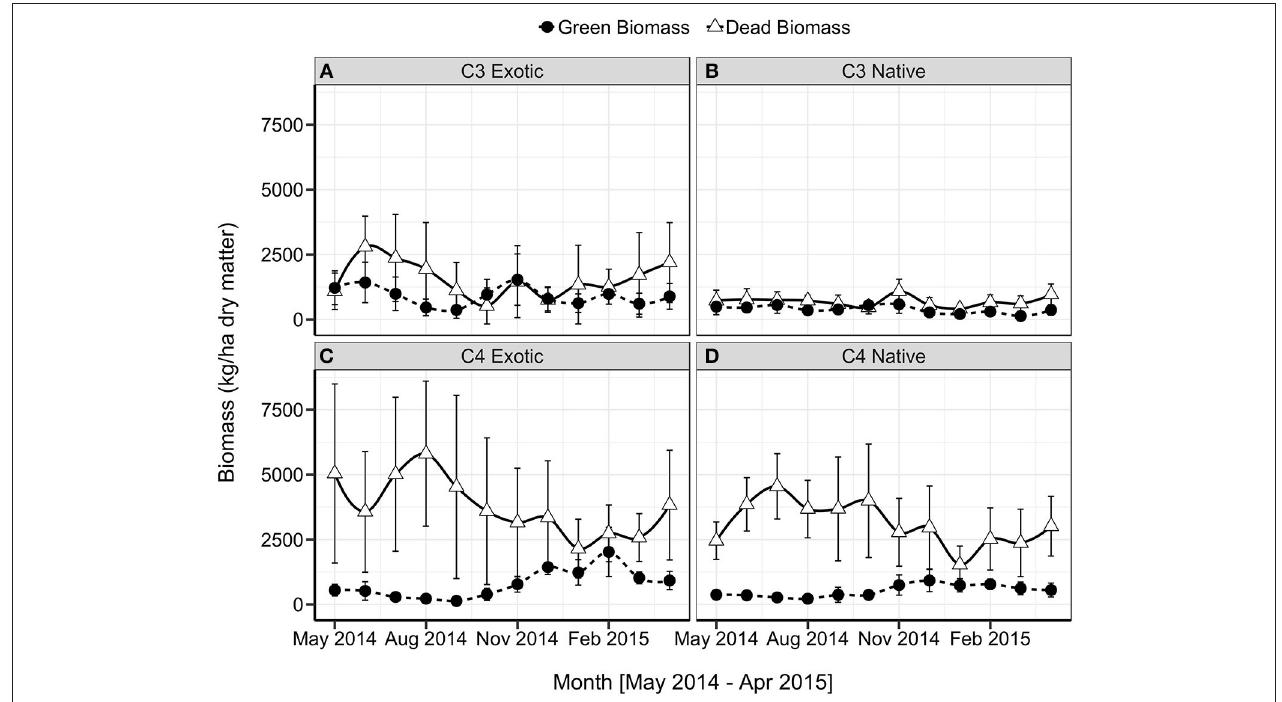
FIGURE 5 | Mean monthly green (solid line) and dead (broken line) biomass (kg/ha ± s.d.; n = 18) by grassland functional type, (A) C 3 Exotic, (B) C 3 Native, (C) C 4 Exotic, (D) C 4